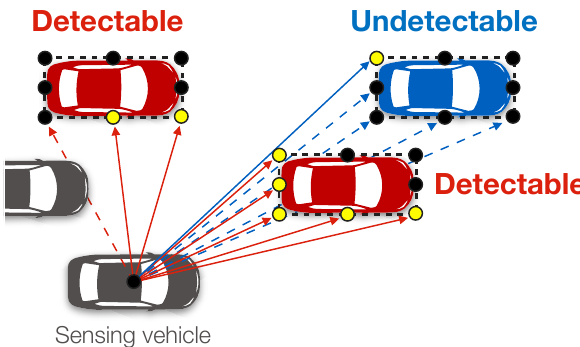
Figure 6. Vehicle detection model in the